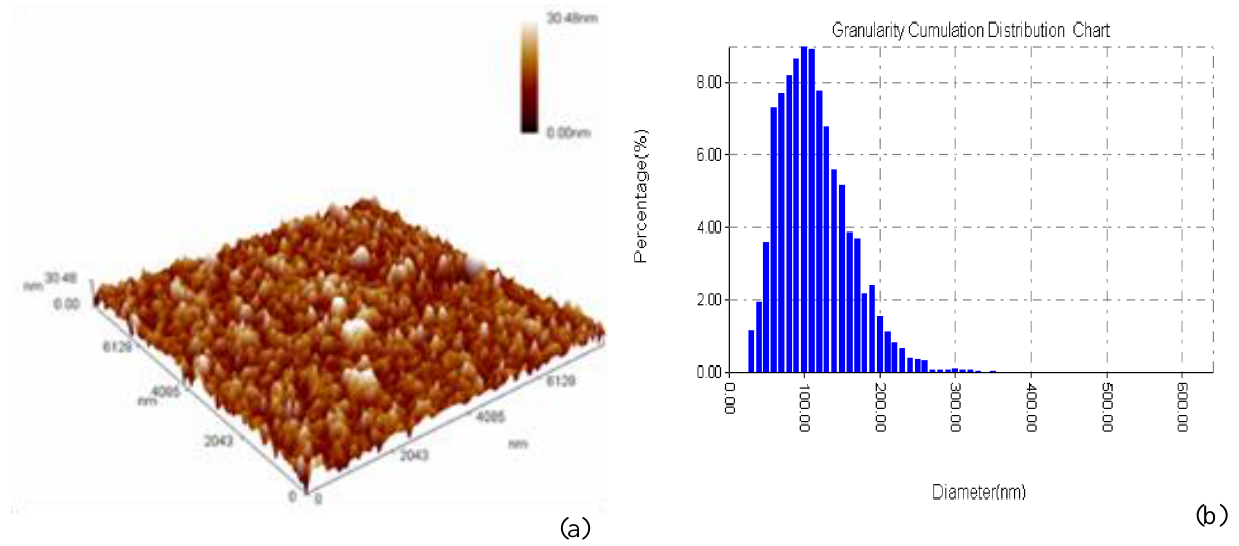
Figure 3. (a) 3D-AFM image of fiber; (b) AFM Granularity accumulation of immobilized A